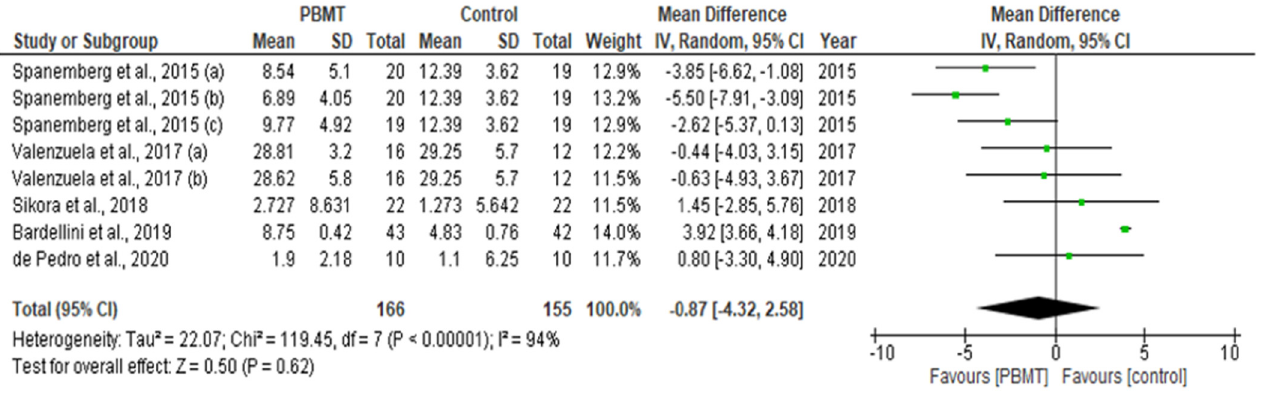
Figure 6. Forest plot for secondary outcome qualitative anxiety/depression and QoL assessment (OHIP) from baseline up to the final follow-up timepoint.